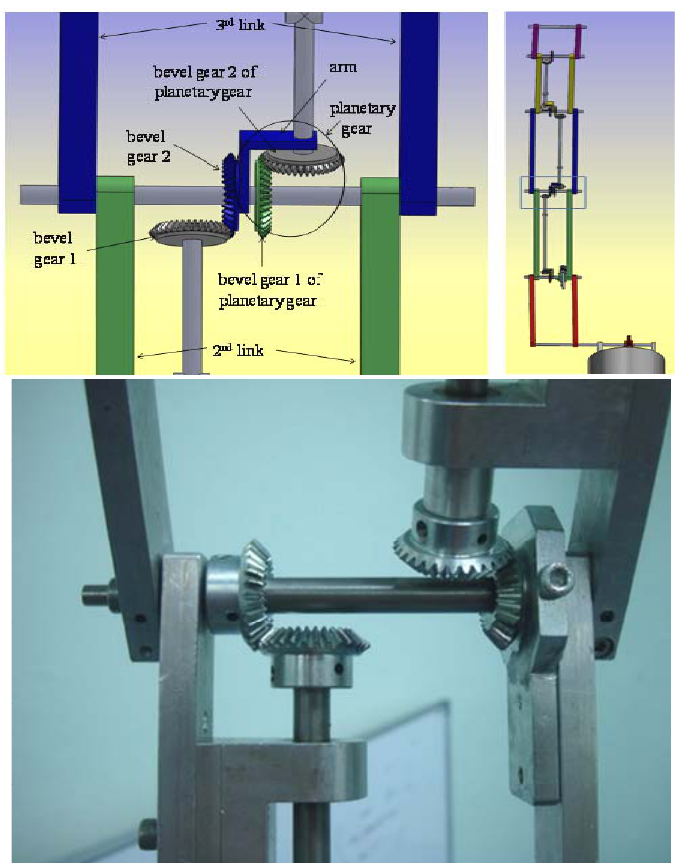
Figure 5. The design of the fourth joint angle (third link) of the manipulator [14]. The draft of the fourth joint angle using the SolidWorks software ( top left ). The draft of the whole manipulator using the SolidWorks software ( top right ). The mechanical design of the fourth joint angle ( bottom ).